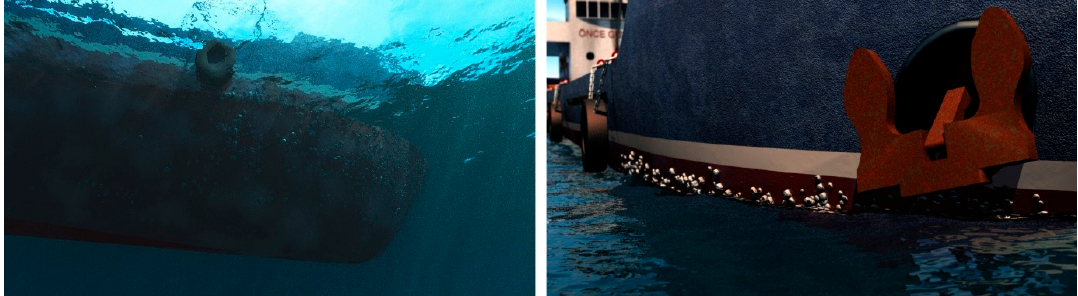
Figure 5. A virtual scene featuring barnacles on the surface of a ship hull.